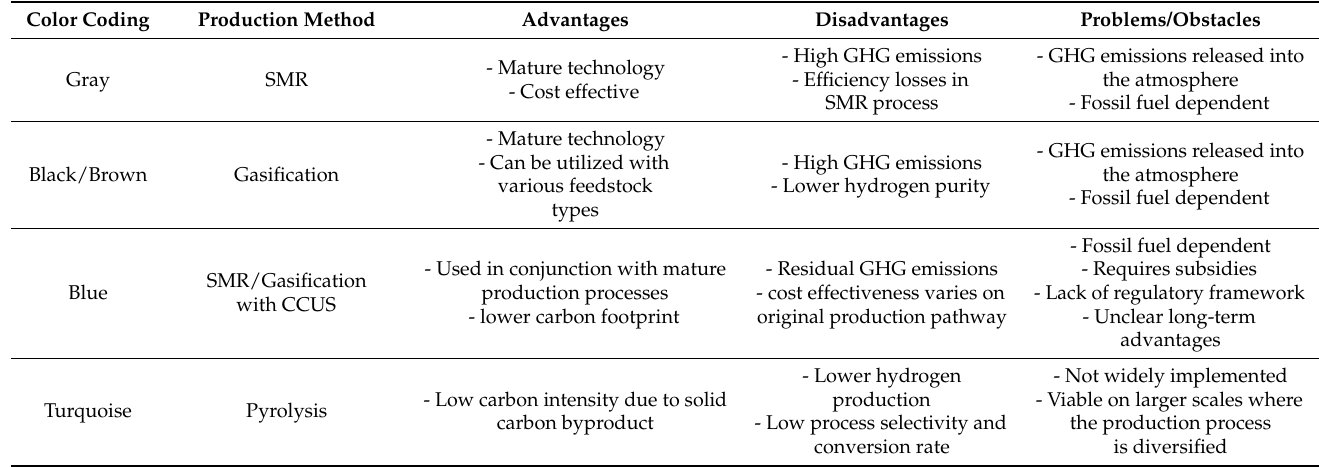
Table 4. Color-coded hydrogen: advantages, disadvantages, problems, and